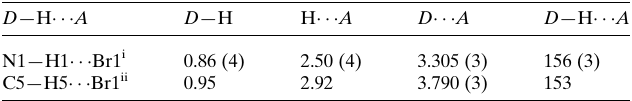
Table 1 Hydrogen-bond geometry (A˚ , (cid:2) ) for 1 .